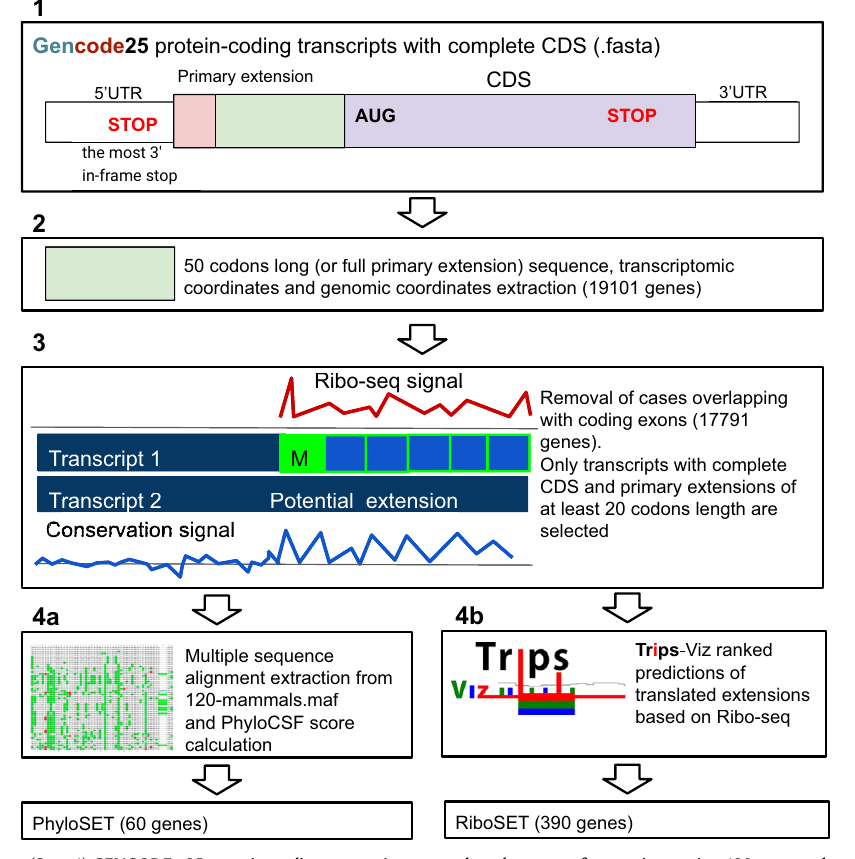
codons-long set of extensions using 120-mammals multiple sequence alignment shown with CodeAlignView; strictly positive threshold led to a set of 60 genes which we called PhyloSET; (step 4b) the retrieval of the ranked extensions pre- dicted based on ribosome pro fi ling data in Trips-Viz browser that composed RiboSET (390